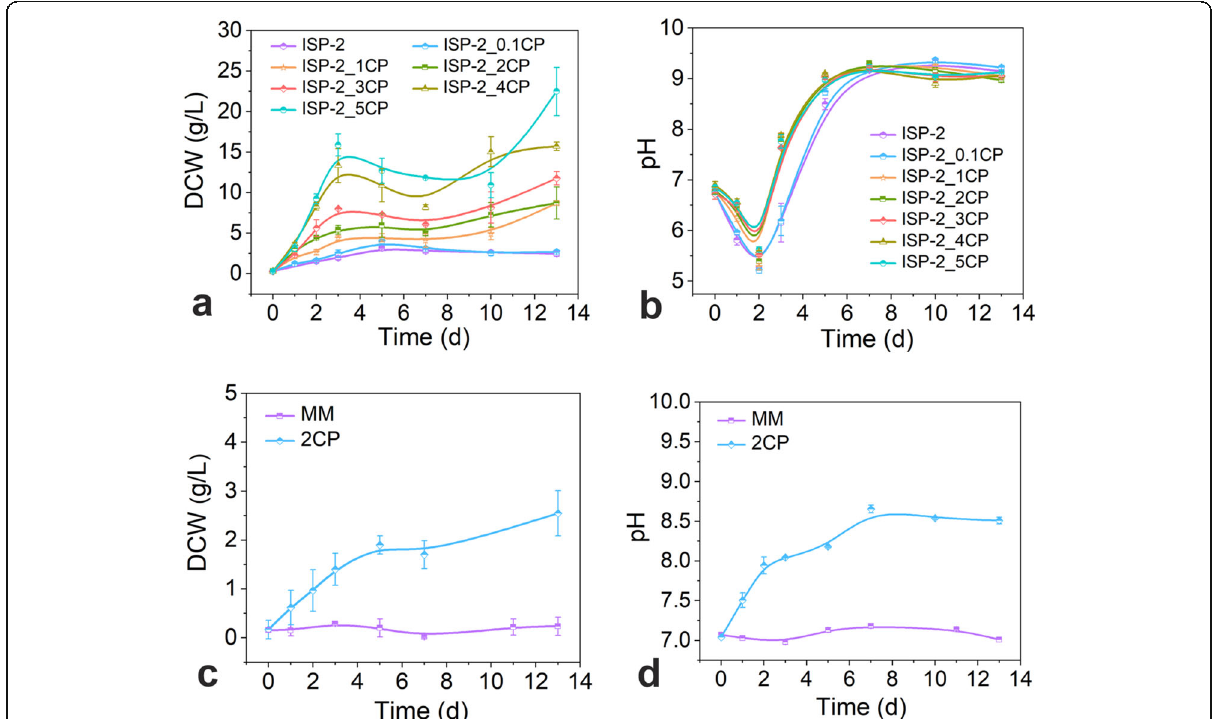
Fig. 1 Influence of CP on the growth behavior of the strain S. coelicolor CGMCC 4.7172. a and b Time course of DCW and pH values in the ISP-2, ISP-2_0.1CP, ISP-2_1CP, ISP-2_2CP, ISP-2_3CP, ISP-2_4CP and ISP-2_5CP media, respectively. c and d The change of DCW and pH values in the MM and 2CP media during the culture process of 13 d,